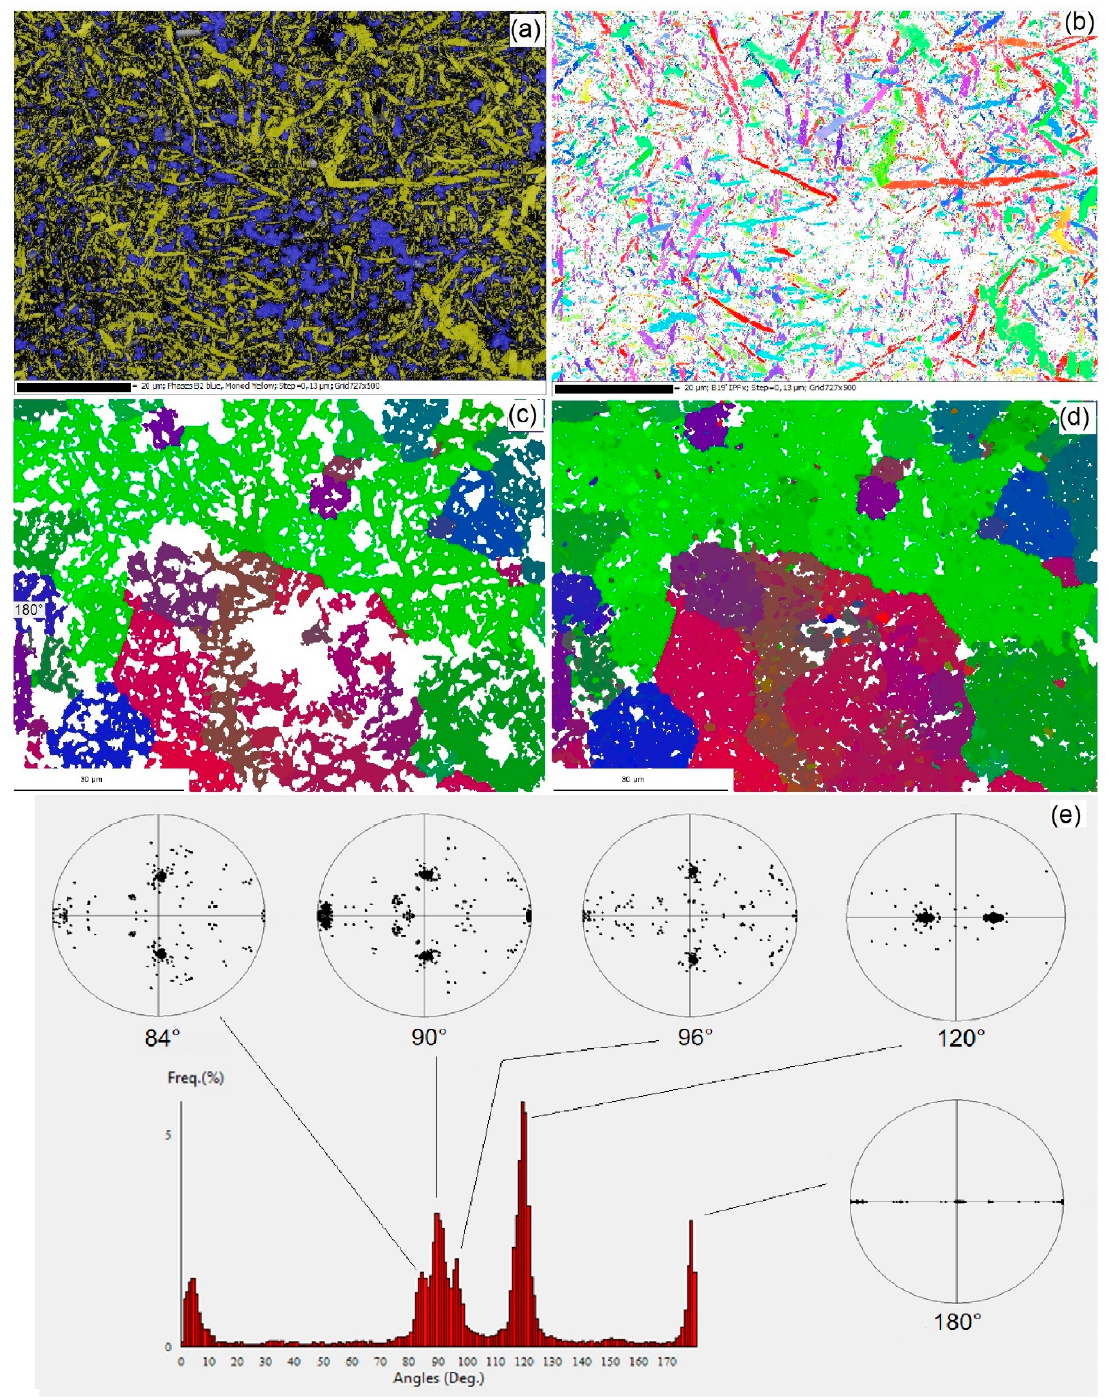
Figure 5. EBSD map 2. ( a ) Phase map with the B19 ′ martensite in yellow and the “reversed” B2 phase in blue, ( b ) orientations of the B19 ′ martensite in IPFx colors, ( c ) B2 parent grains reconstructed by ARPGE from the B19 ′ martensite, ( d ) same map overlapped with the “reversed” B2 grains in IPFz colors, ( e ) histogram of disorientations between the B19 ′ martensite present in the reconstructed parent B2 grains. The corresponding rotation axes are plotted in a pole figure according to the convention explained in Figure 6. The scale bar in the maps ( a ) and ( b ) is 20 μ m, and that in the maps ( c ) and ( d ) is 30 μ m.